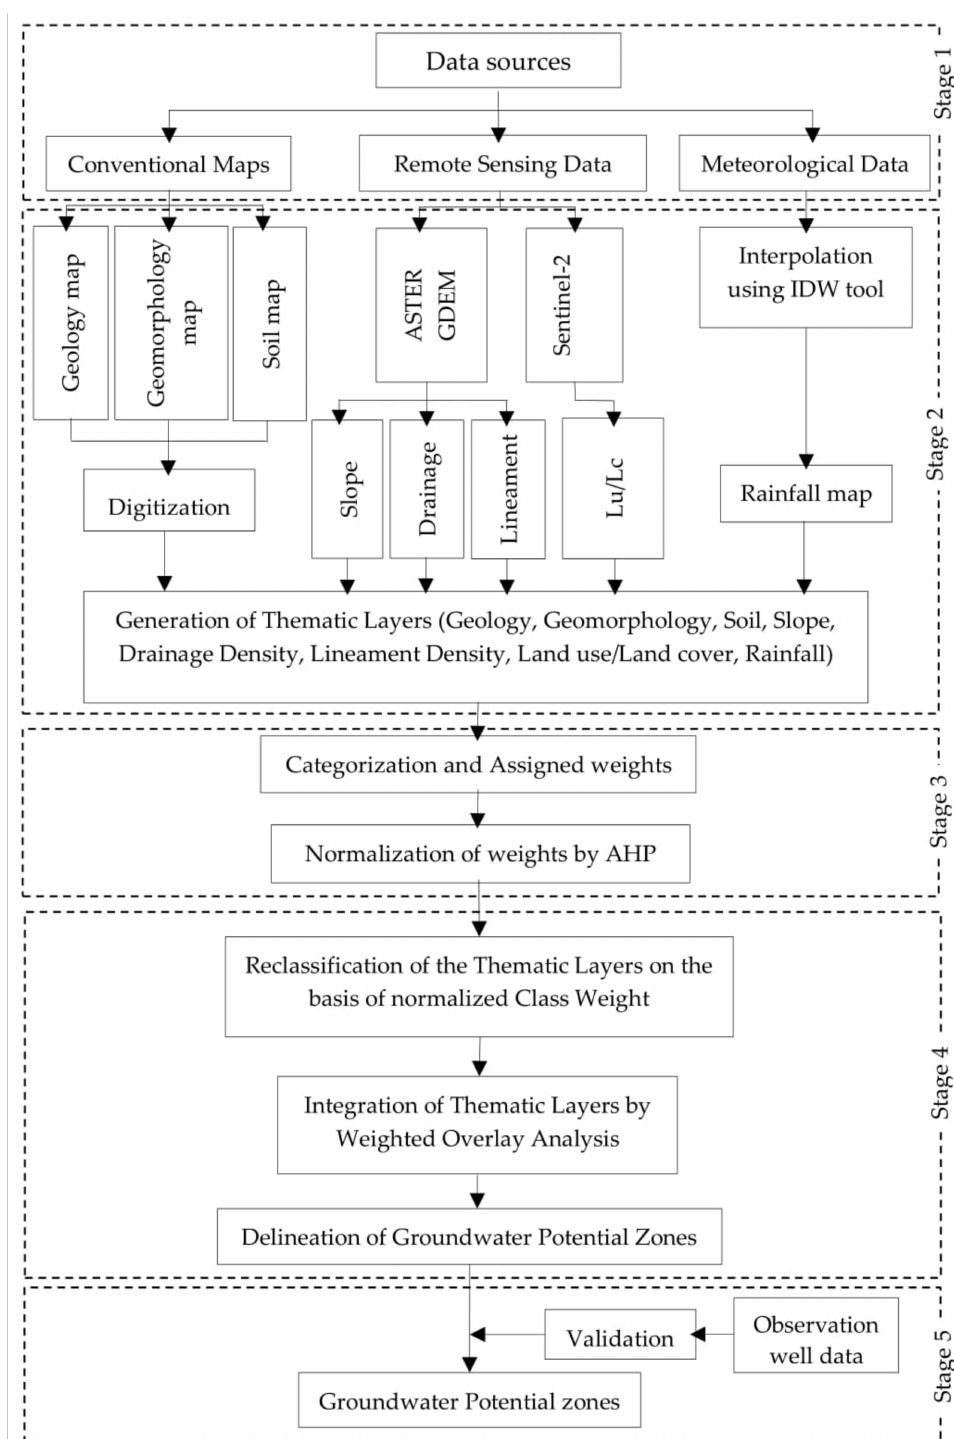
Figure 3. Flowchart of the methodology used for delineating potential groundwater zones (Stage 1—Data collection, Stage 2—Creation of geospatial maps, Stage 3—Weight assignment, Stage 4—Creation of potential groundwater zone, Stage 5—Validation of developed groundwater potential